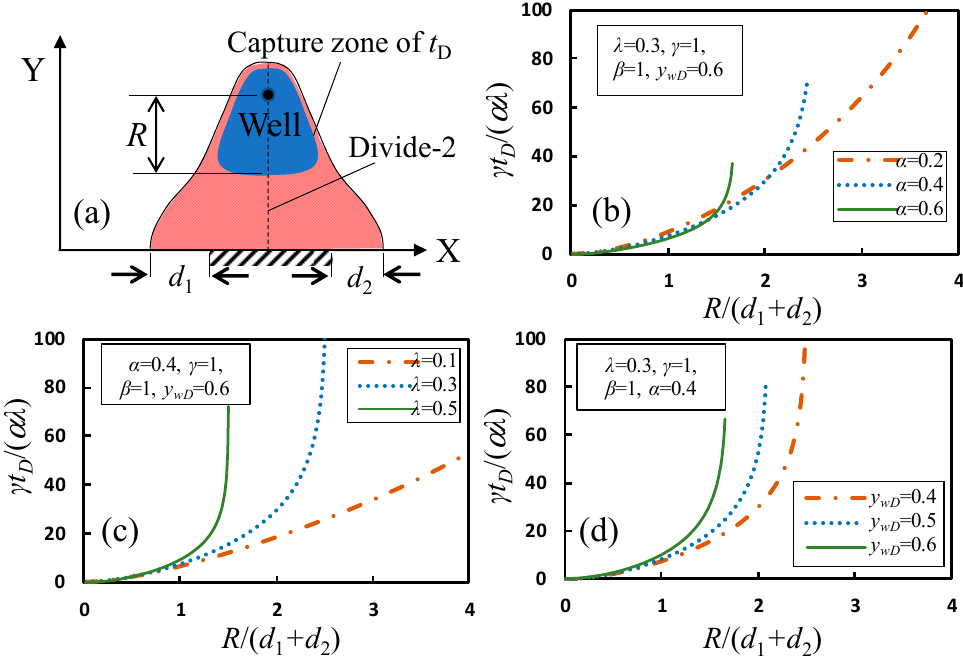
Figure 14. The size factor of a capture zone ( a ) with limited travel time in a Type-III catchment for a well on Divide-2 and the curves of γ t D /( α λ ) versus R / d with varying α ( b ), λ ( c ) and y wD ( d ).